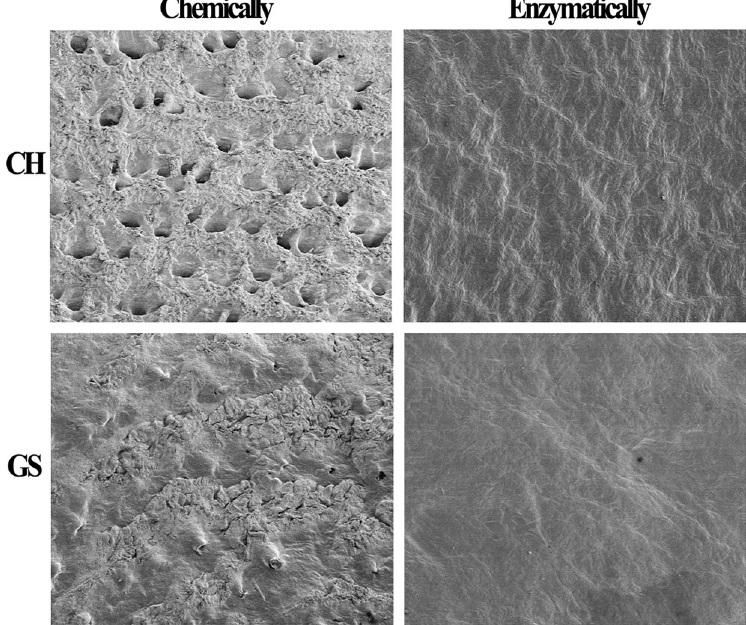
Figure 8. SEM images for the grain surface of chemically and enzymatically dehaired cattle hide and goat skin with × 30 magnification. CH represents cattle hide; GS represents goat